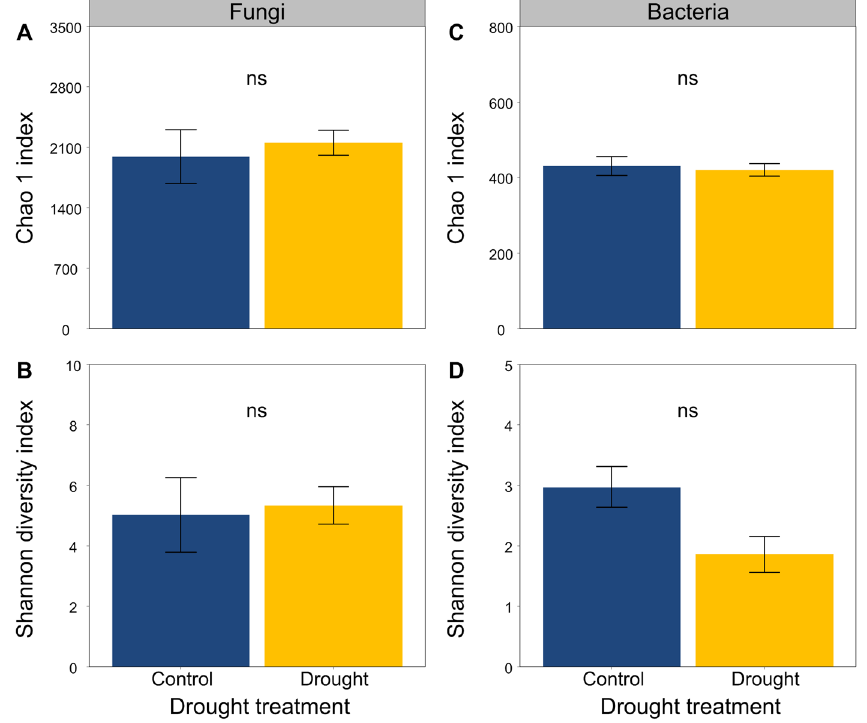
Figure 4. Effects of drought on soil microbial biomass carbon. Mean ± SE are shown (n = 12). Different lowercase letters indicate significant differences at p < 0.05 (Tukey’s HSD).